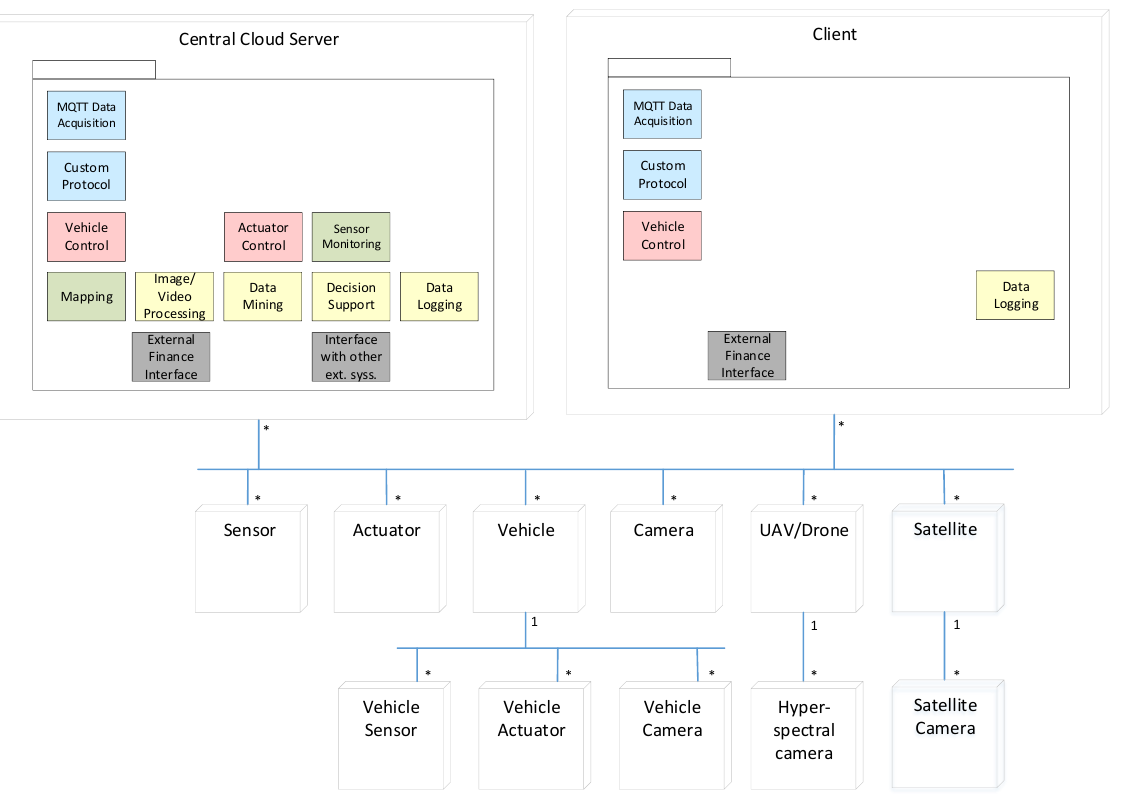
Figure 10. Deployment View for Smart Charging System (1 and * stands for one to many relation).